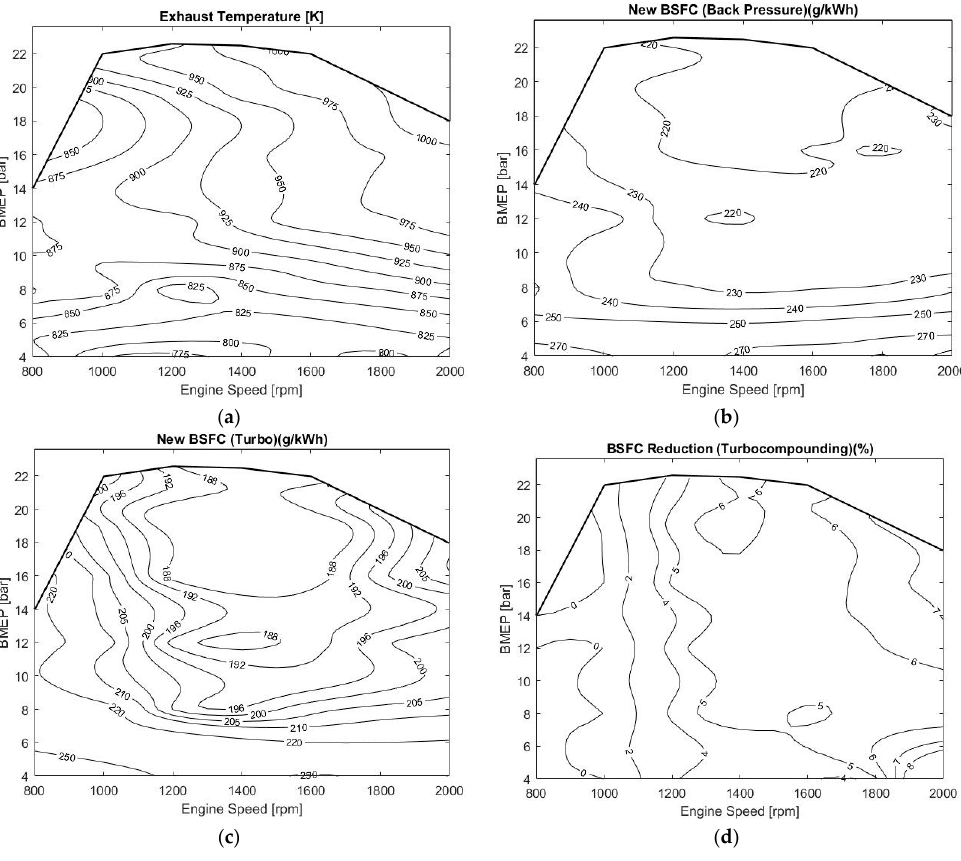
Figure 5. Turbocompounding system map of engine: ( a ) Increased exhaust temperature in turbocompounding system based on BMEP map; ( b ) BSFC Rise due to Back Pressure turbocompounding system based on BMEP map; ( c ) New BSFC of engine with turbocompounding system based on BMEP map; ( d ) Amount of BSFC reduction in engine with turbocompounding system based on BMEP map.